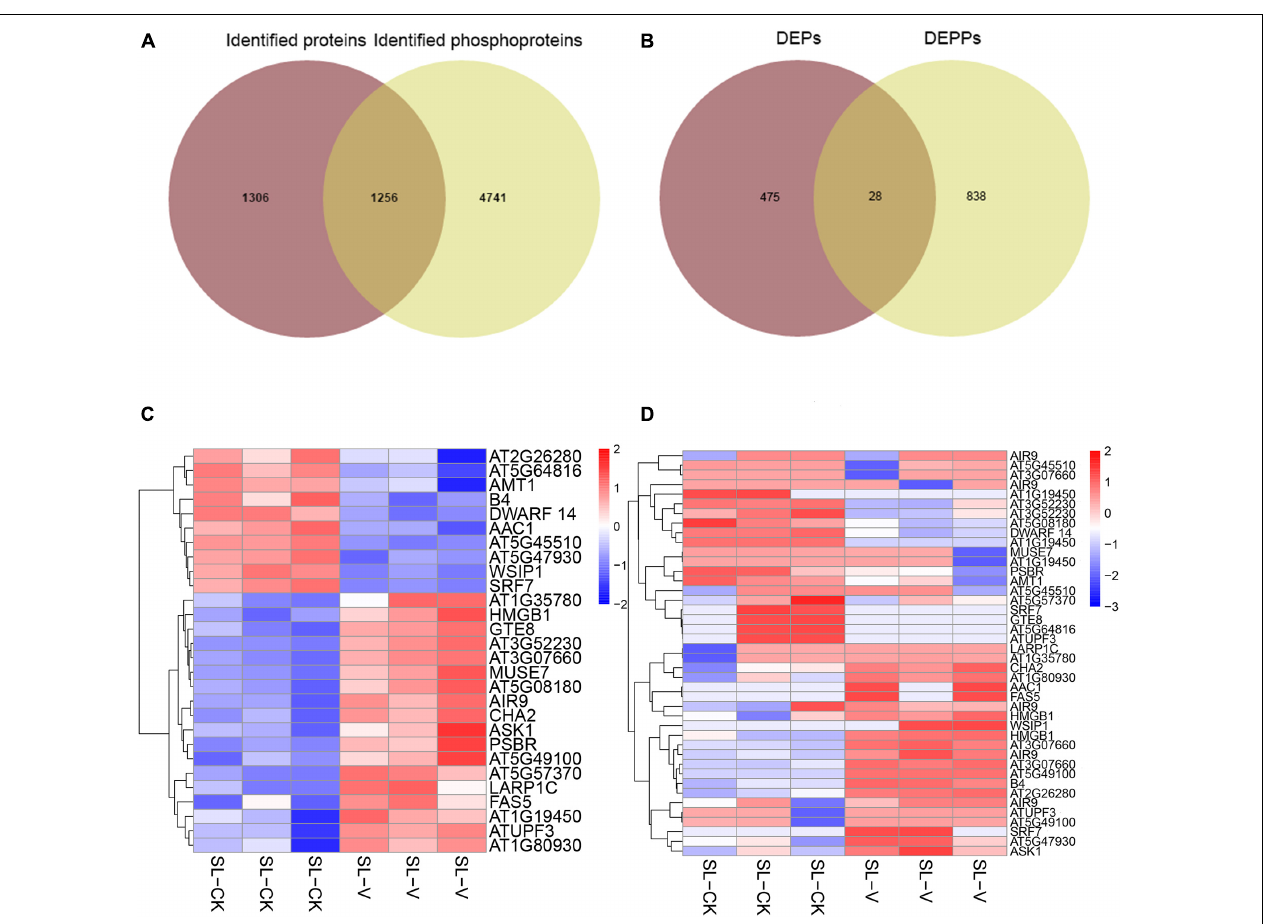
FIGURE 7 | Comparative analyses of proteome and phosphoproteome. (A) Overlap of identified phosphoproteins and identified proteins. (B) Overlap of significantly changed proteins and significantly changed phosphoproteins. (C) Heat map of significantly changed proteins from systemic leaves of Psm ES4326 and mock locally inoculated plants. (D) Heat map of significantly changed phosphopeptides from systemic leaves of Psm ES4326 and mock locally inoculated plants. DEPs, differentially expressed proteins; DEPPs, differentially expressed phosphoproteins. Analytical procedures are as described in Figure 6B